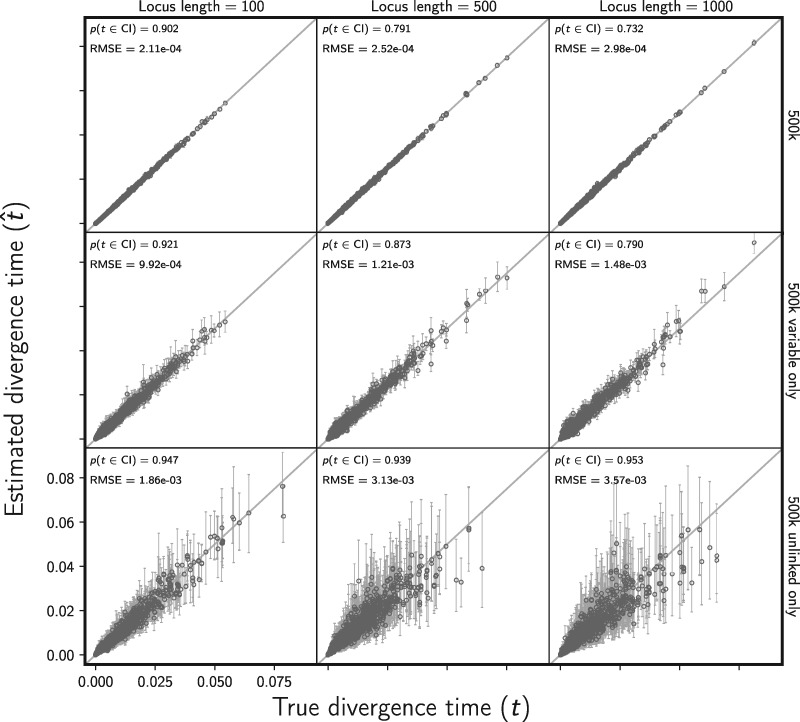
Assessing the effect of linked sites on the accuracy and precision of divergence time estimates (in units of expected subsitutions per site). The columns, from left to right, show the results when loci are simulated with 100, 500, and 1000 linked sites. For each simulated data set, each of three population pairs has 500,000 sites total. The rows show the results when (top) all sites, (middle) all variable sites, and (bottom) at most one variable site per locus are analyzed. For each plot, the root mean square error (RMSE) and the proportion of estimates for which the 95% credible interval contained the true value—\documentclass[12pt]{minimal}
\usepackage{amsmath}
\usepackage{wasysym}
\usepackage{amsfonts}
\usepackage{amssymb}
\usepackage{amsbsy}
\usepackage{upgreek}
\usepackage{mathrsfs}
\setlength{\oddsidemargin}{-69pt}
\begin{document}
}{}$p({{t}}\in \textrm{CI})$\end{document}—is given. We generated the plot using matplotlib Version 2.0.0 (Hunter 2007)